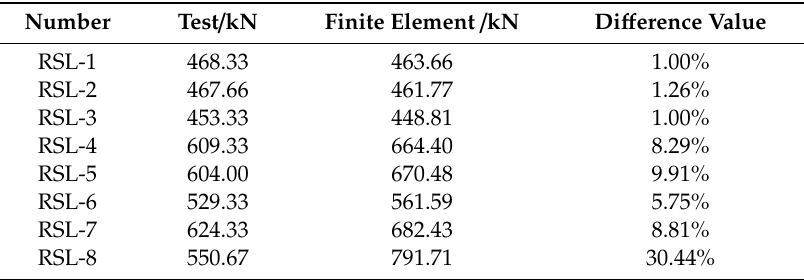
Table 9. Comparison table of test and finite element.